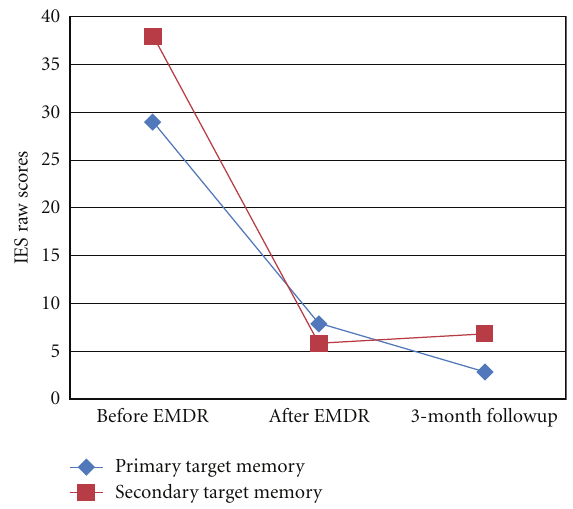
Figure 2: Scores of Impact of Event Scale [14] in pretreatment, posttreatment, and three-month followup. Note : the scores of the two target memories dropped below 9 (i.e., having low impact) in post-EMDR and 3-month followup